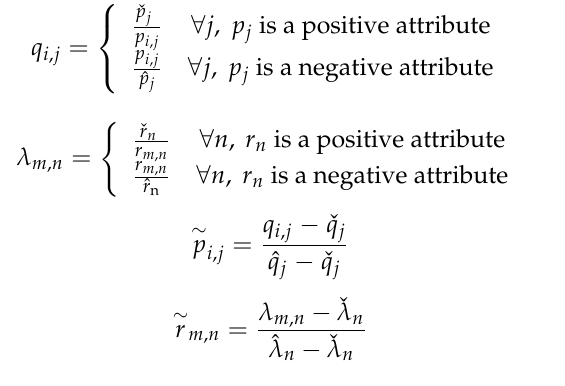
The separation of motor vehicles and non-motor vehicles - Cost of time - Toll fee - The number of traffic lights - The number of intersections - The number of turns